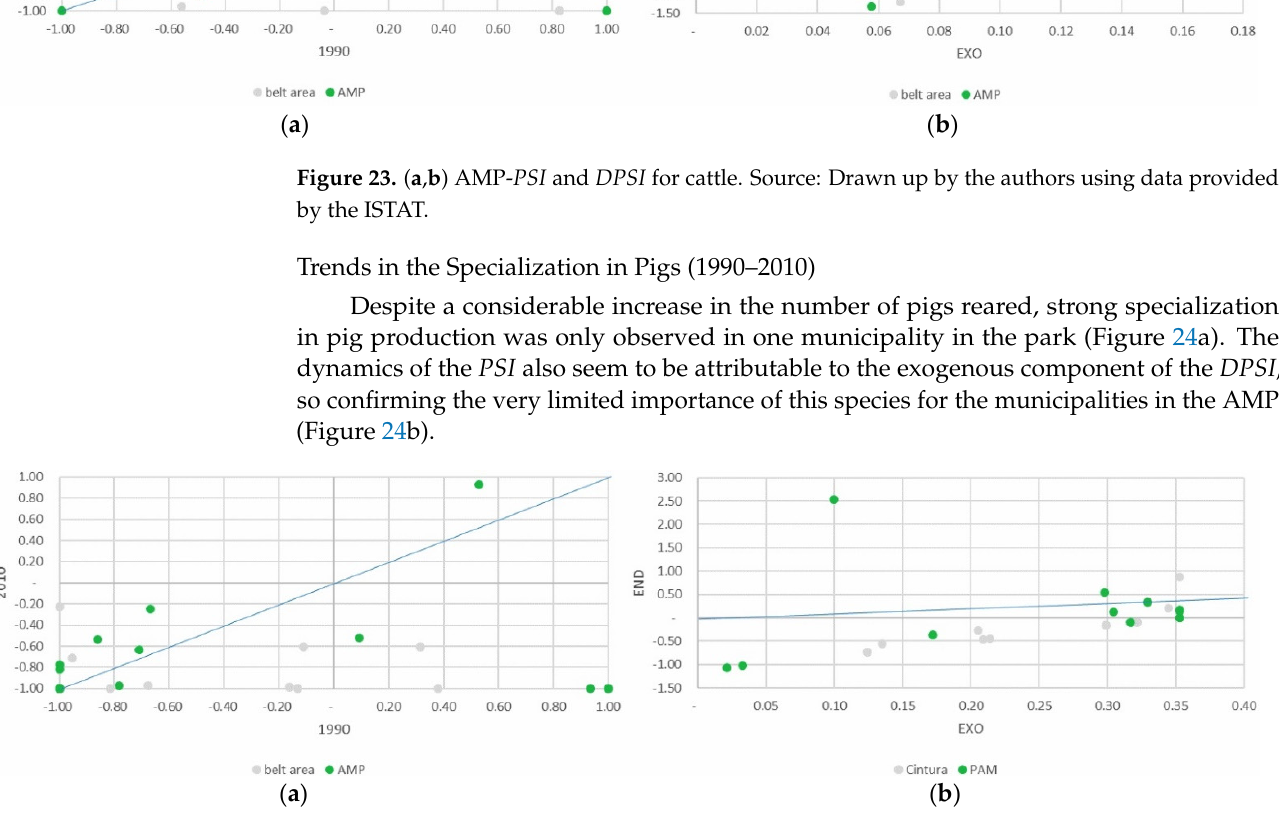
Figure 25. ( a , b ) AMP- PSI and DPSI for sheep. Source: Drawn up by the authors using data provided by the ISTAT.